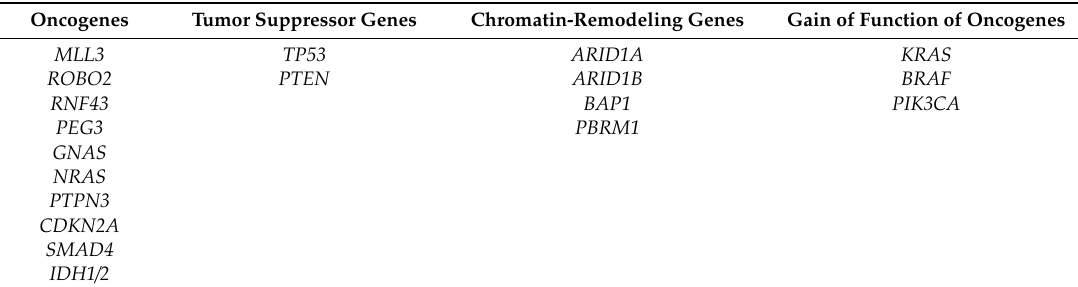
Table 1. Genetic alterations of related oncogenes in human